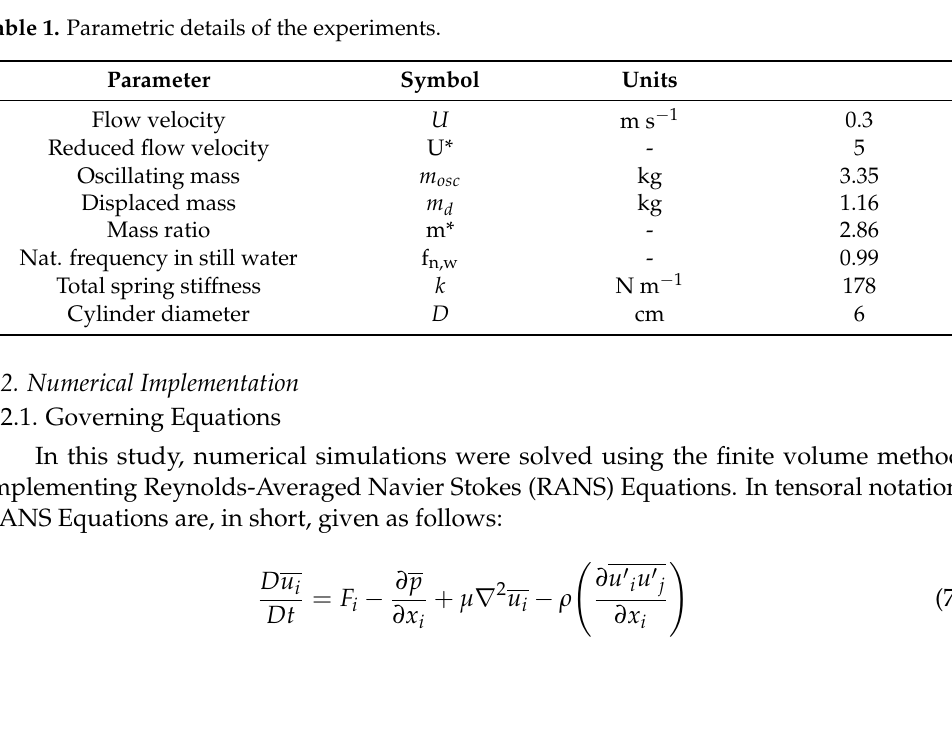
Figure 6. Positions of cylinder during one oscillation (not to scale). The VIV motion was captured by the open-source electronics platform, Arduino (https://www.arduino.cc, accessed on 11 November 2022). Arduino boards have a number